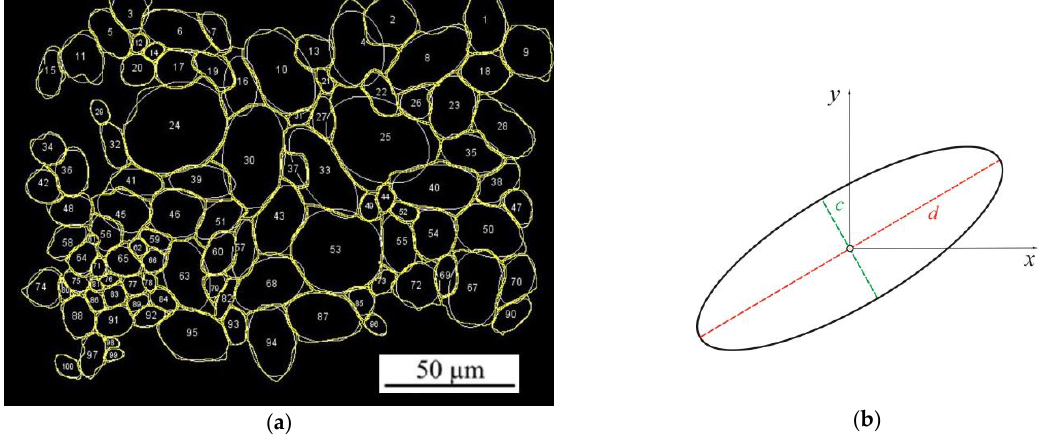
Figure 15. ( a ) Sectional view of the prior austenite microstructure after thermal etching at 1100 °C (redrawn from [31] and analyzed by Fiji [48]). The grains are approximated by ellipses. ( b ) Ellipse with major axis d and minor axis c. A column plot shows the distribution of the ratio A is the mean area of the grain (Figure 16). The m